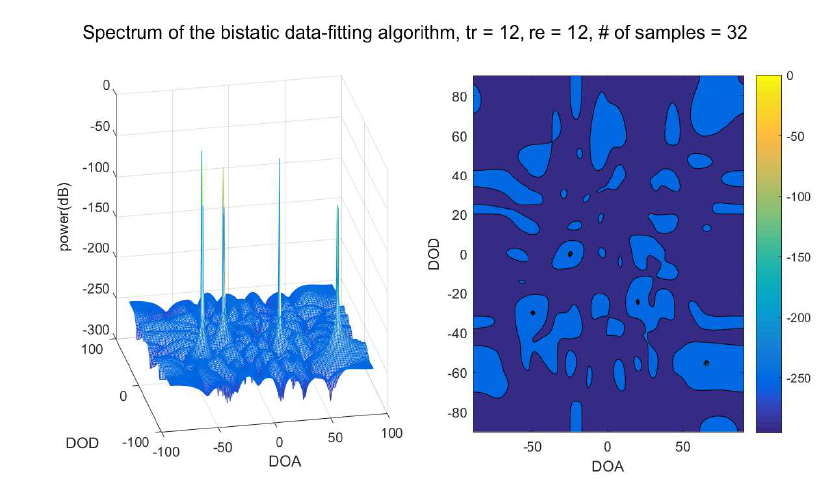
Figure 9. Spectrum of the bistatic data fitting algorithm, the number of targets = 4 (case 2).